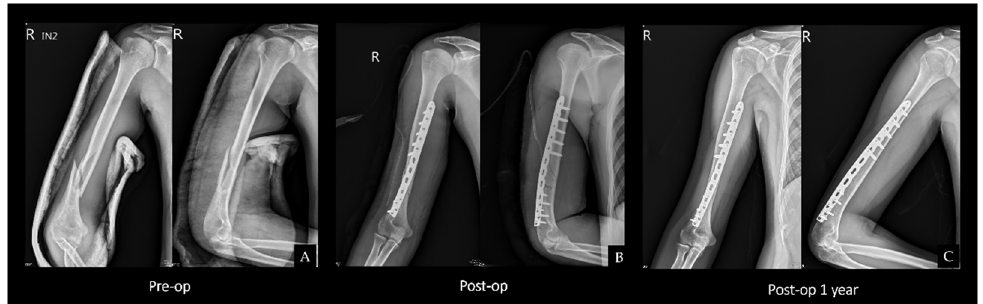
Figure 3. ( A ) Anteroposterior and lateral views showing a spiral fracture. ( B ) Postoperative radio- graphs showing the fixation with an AO LCP Metaphyseal Plate using a triceps-sparing approach. ( C ) One-year postoperative radiographs revealing bone union. Abbreviations: LCP = locking com- pression plate. R= right.